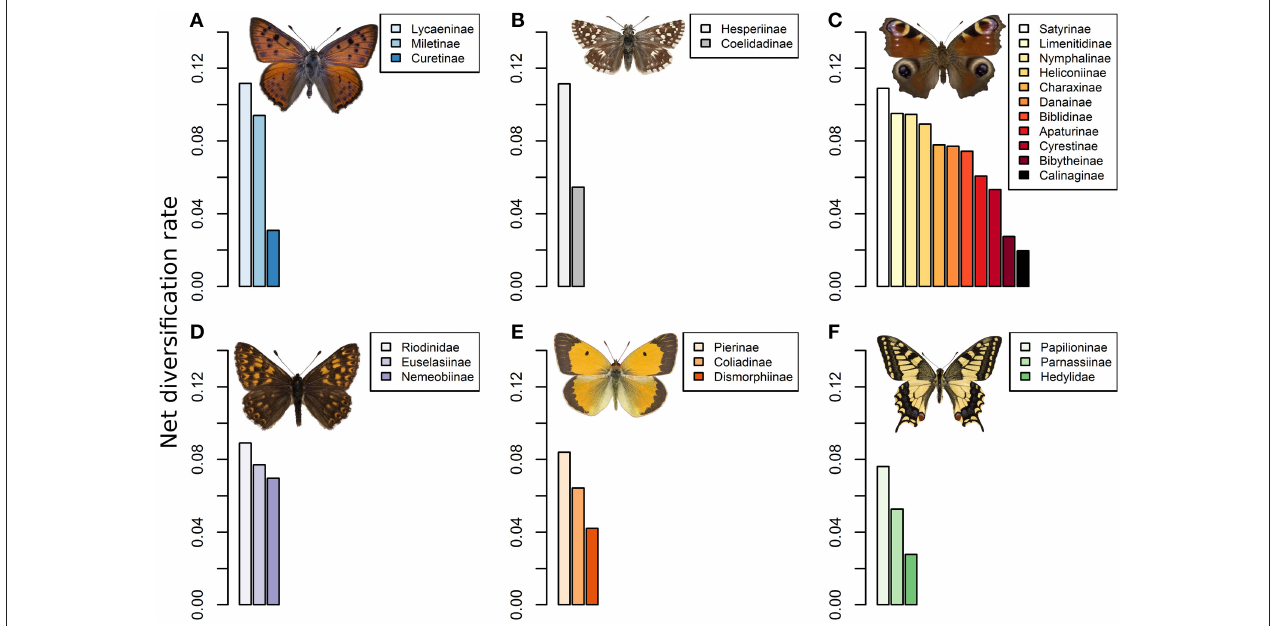
FIGURE 2 | Barplots of the net diversification rates estimated for each butterfly clade from the dated phylogeny of Heikkilä et al. (2012) and species richness estimates. Shown for (A) Lycaenidae, (B) Hesperridae, (C) Nymphalidae, (D) Riodinidae, (E) Pieridae, and (F) Papilionidae. Diversification was computed using the method-of-moments estimator for stem group